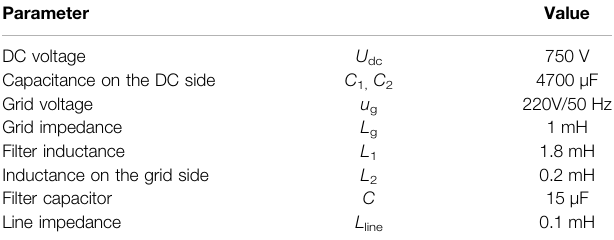
TABLE 1 | Parameters of the grid-connected